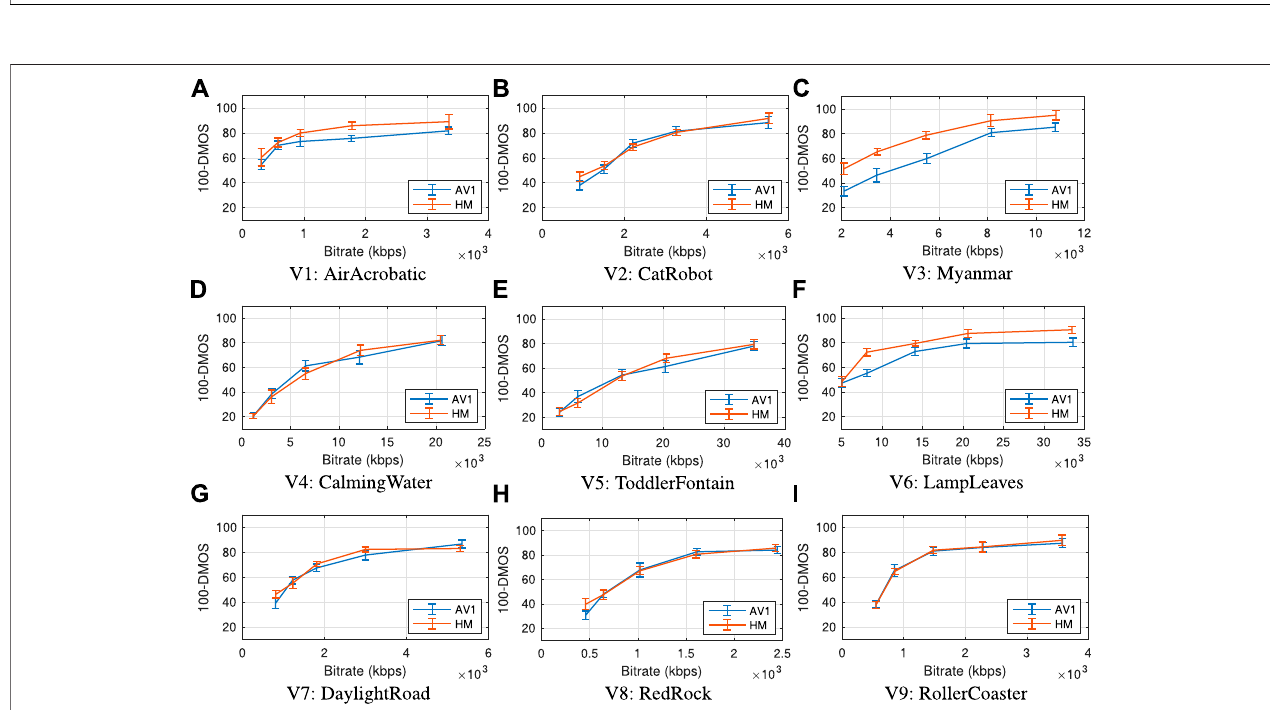
FIGURE 7 | The DMOS-Rate curves for all sequences (A – I) of Resolution Group C and all three codecs along with the standard error bars after compensating for subject bias, as described in Recommendation P.913 (2021).